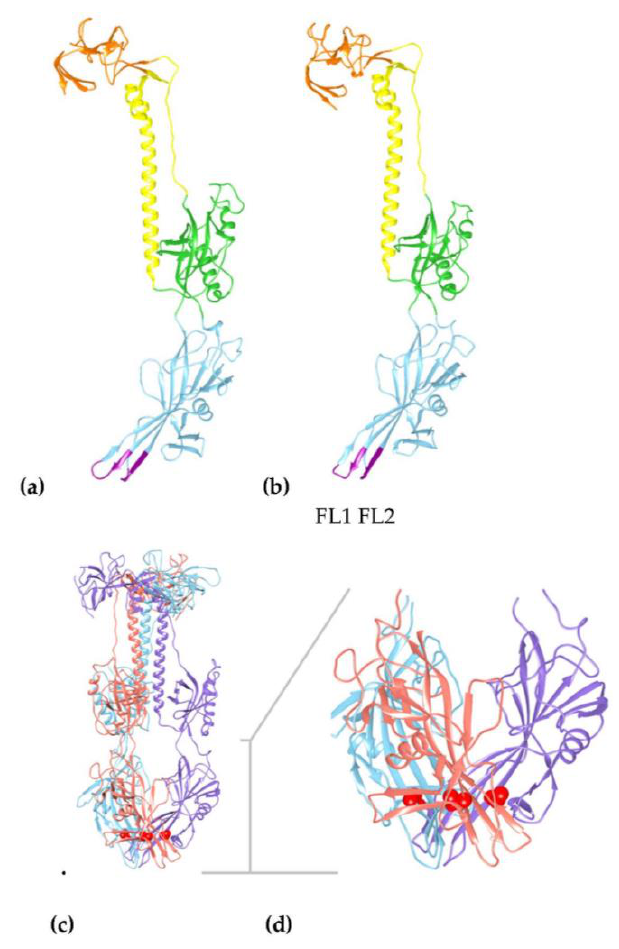
Figure 3. Structural models of HHV-6A gB show conservation with HCMV gB structure identifying the passaged virus has a mutation in the fusion associated domain I affecting the trimer interface. ( a ) Model of the HCMV reference strain Merlin (ectodomain in residues 91–642 from a total of 907), alignment with corresponding region of HHV-6A gB is shown in the Figures S1–3. ( b ) Model of HHV-6A gB ectodomain, in the corresponding residues 38 to 579 (total 839 residues) using multiple templates of pdb (RCSB protein database) folds from gB HCMV strain AD169 (PDB ID: 5cxf) and strain Towne (PDB IDs: 4osn, 5c6t), gB EBV strain B95-8 (PDB ID: 3fvc), and gB HSV-1 strain KOS (PDB IDs: 2gum and 3nwa). Using the structure of most closely related HCMV gB, as a model, shows Domains I (blue), II (green), III (yellow), and IV (orange) in the post-fusion conformation. Domain I (blue) shows conserved beta sheets connected by the two fusion loops, FL1 and FL2, at the base of the model (purple). ( c ) Longitudinal view of the predicted trimer of HHV-6A gB showing the Thr193 position in red within three subunits, indicated in purple, blue, and orange. ( d ) Domain I (residues 79–291) is enlarged as indicated by the grey T bar, showing the position of Thr193, in red, in the beta sheet at the trimer interfaces with the fusion loops FL1 (residues 100–105) and FL2 (residues 184–191) exposed at the base of the structure.